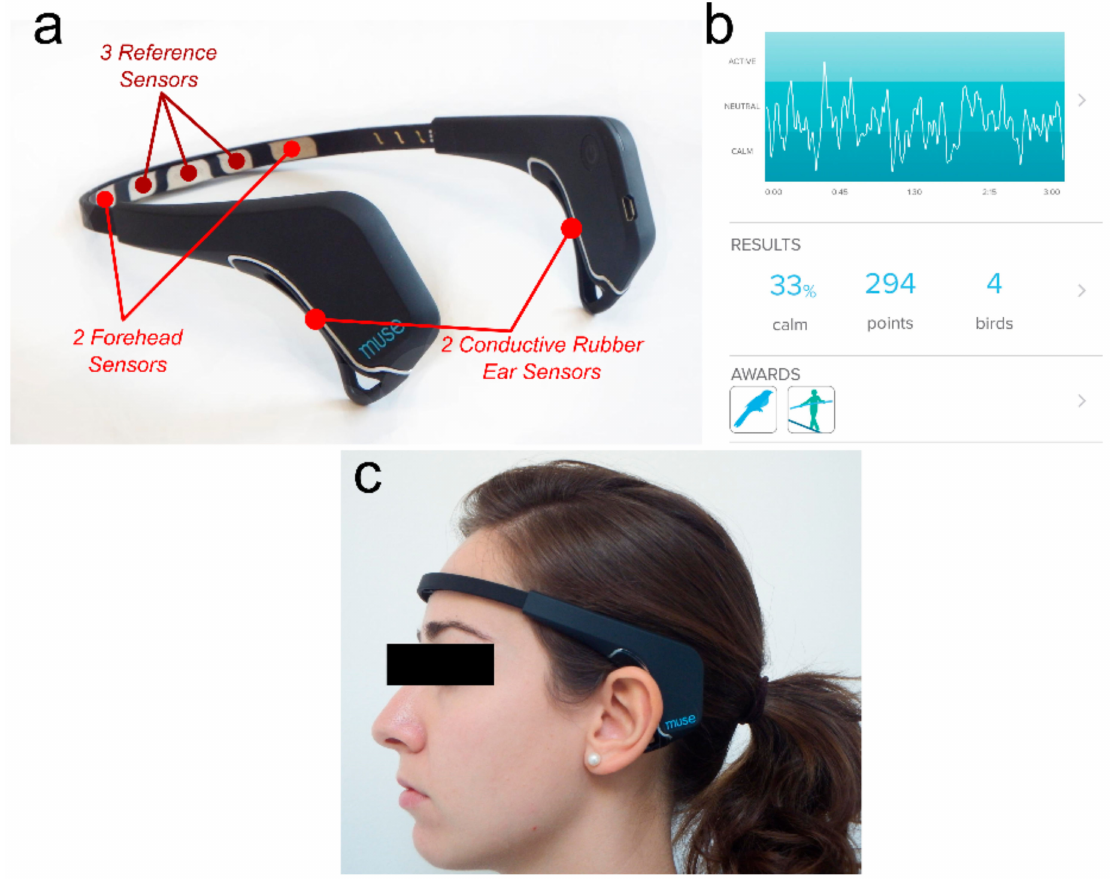
Figure 1. The Muse™ wearable device, a commercial brain-sensing headband devised to support meditation practices. The device pairs with a dedicated smartphone app and uses electroencephalographic (EEG) frequency data to provide the user with real-time acoustic feedback on his/her oscillatory brain activity. ( a ) The wearable device. Red dots mark the position of embedded EEG dry sensors; ( b ) An example of a post-session feedback screen; ( c ) Placement of the brain-sensing